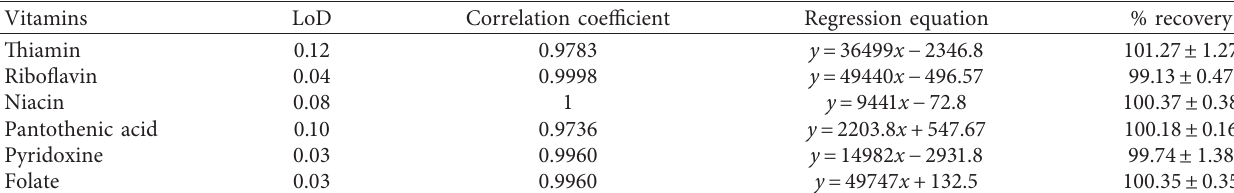
Table 1: Method validation parameters of vitamin B